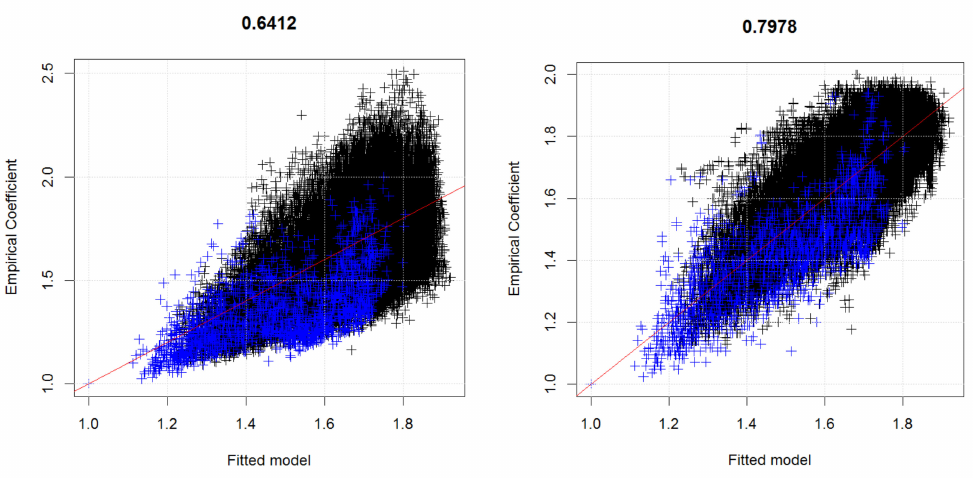
Figure A1. Extremal coe ffi cient θ ( s , t ) obtained by the model with m = 7 and n = 4 against the empirical θ ( s , t ) estimated with the madogram ( left ) and with Formula (2) ( right ). The resulting correlation is given on top. Blue dots refer to points for river-connected stations.